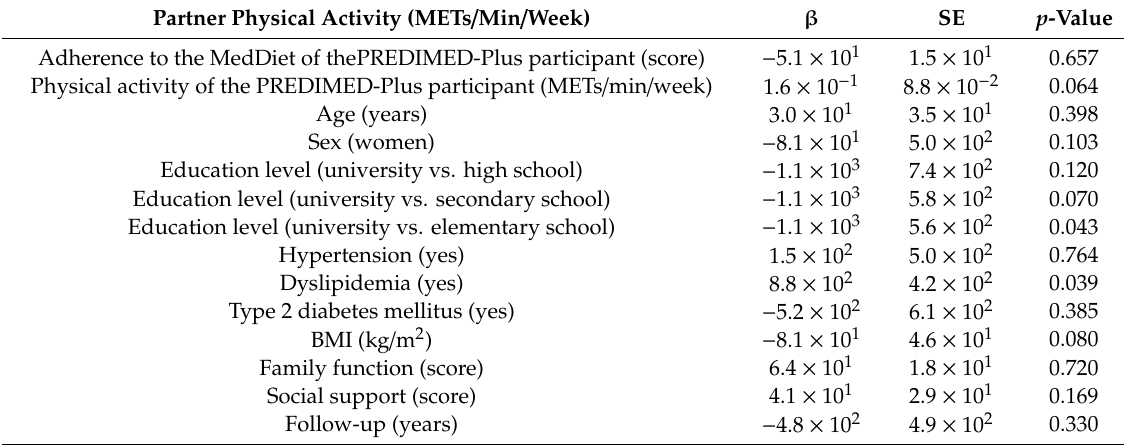
Table 5. Associations between adherence to the physical activity of PREDIMED-PLUS participants and adherence to the physical activity of their household